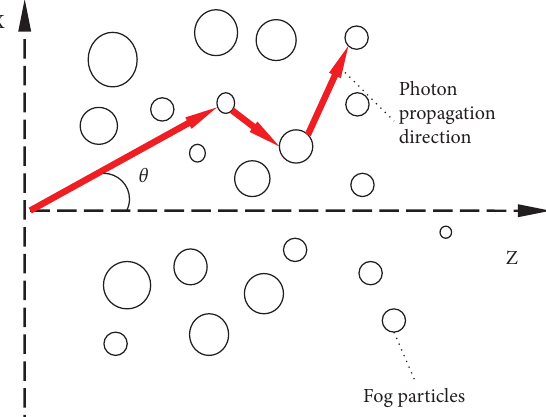
Figure 1: Photon propagation in the fog.